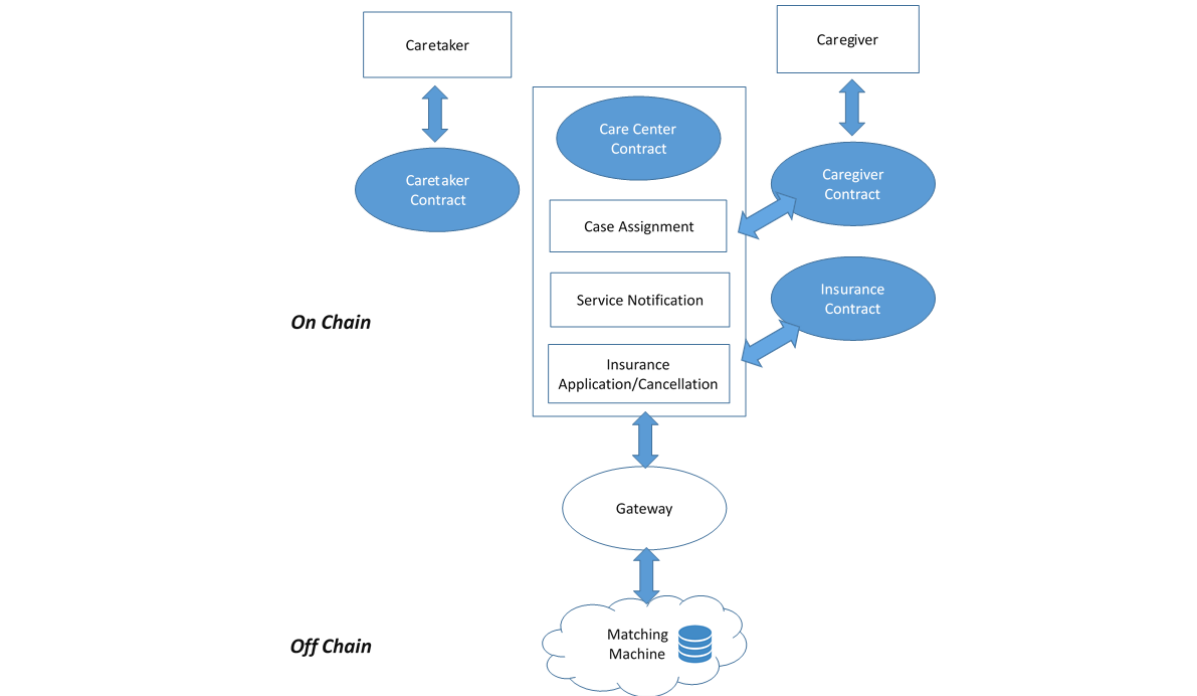
Figure 3. Overview of the blockchain and smart contract–enabled home care system.